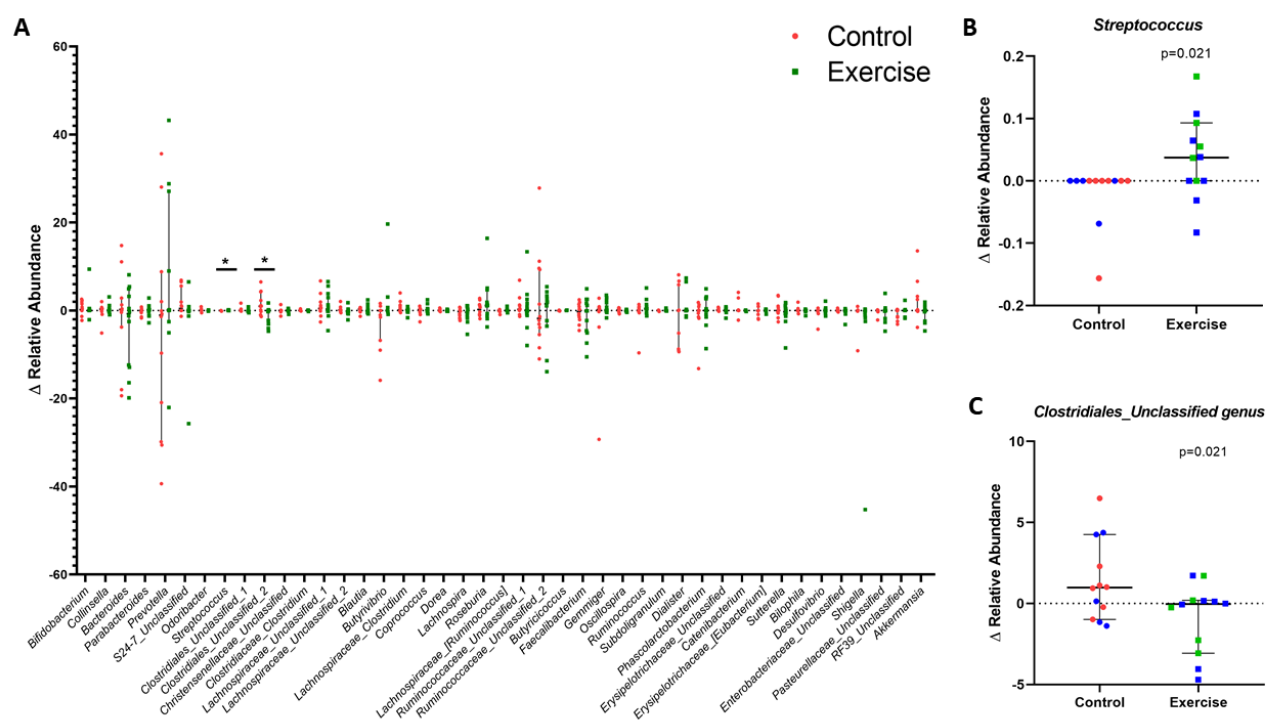
Figure 4. Intragroup variations revealed significant differences between Groups. ( A ) Median and CI95% for genera detected in ≥ 25% of samples. Asterisk means a significant difference between Groups ( p > 0.05). ( B ) Median and CI95% for Streptococcus and ( C ) Mean with CI95% for the genus of Clostridiales order. Each point refers to the delta ( ∆ ) of one subject. Red spheres are Control subjects while green squares are subjects from Exercise Group. Blue points are individuals with BMI > 25 kg/m 2 .